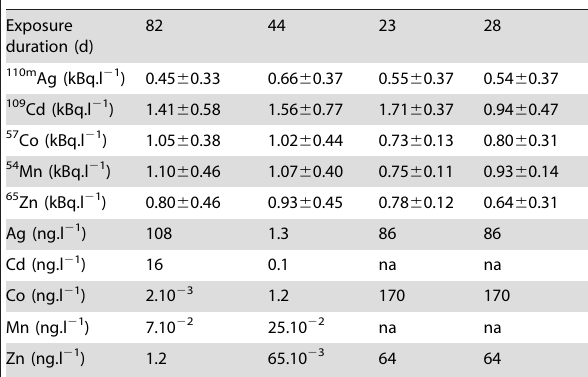
Table 1. Exposure duration expressed in days (d) and radiotracer activities in seawater (mean 6 SD) during experimental